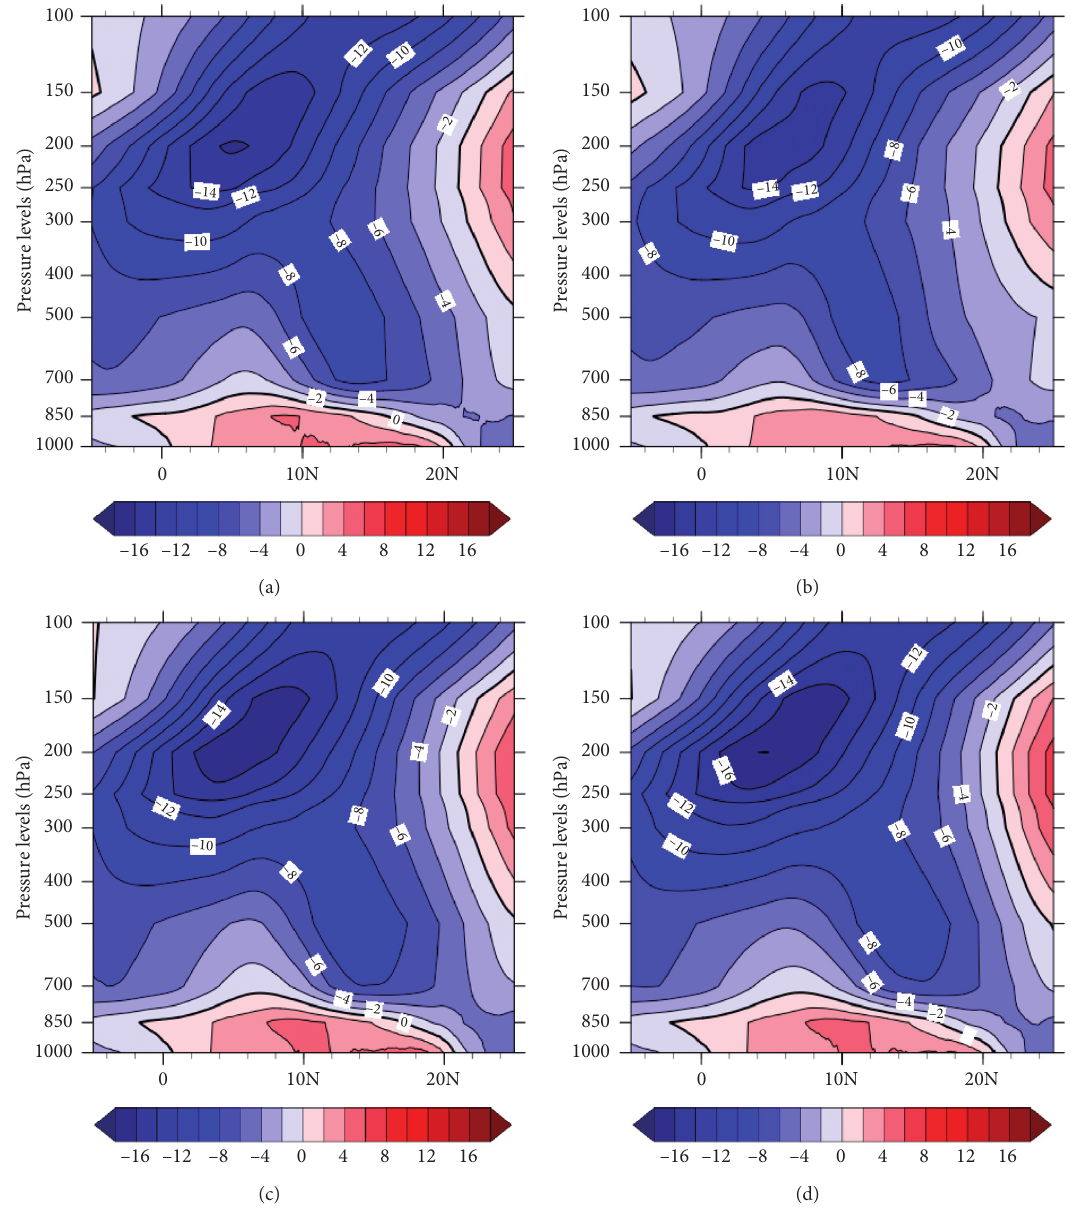
Figure 13: The vertical cross section of the zonal wind (m/s) over West Africa from July 16 th –Sept 29 th , 2012. (a) CLM4. (b) Naoh. (c) Noah- MP. (d) Noah-MP groundwater